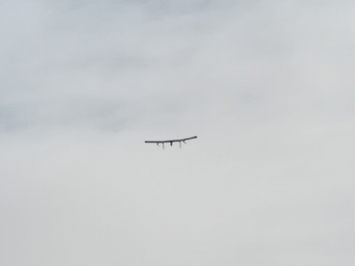
Figure 13. The high aspect ratio full-wing UAV for the flight experiments.